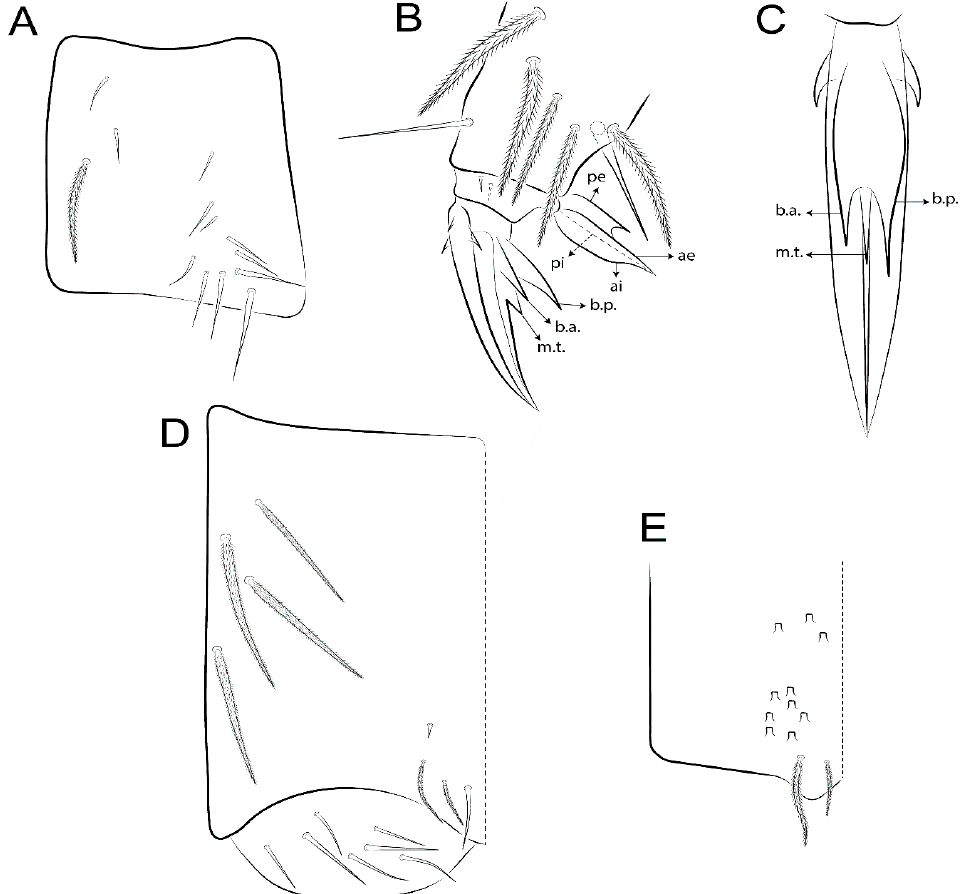
Figure 27. Pseudosinella paraensis sp. nov.: trunk appendages. ( A ) trochanteral organ; ( B ) distal tibiotarsus and empodial complex III (anterior view); ( C ) unguis (inner view); ( D ) collophore (lateral view); ( E ) distal part of manubrium (ventral